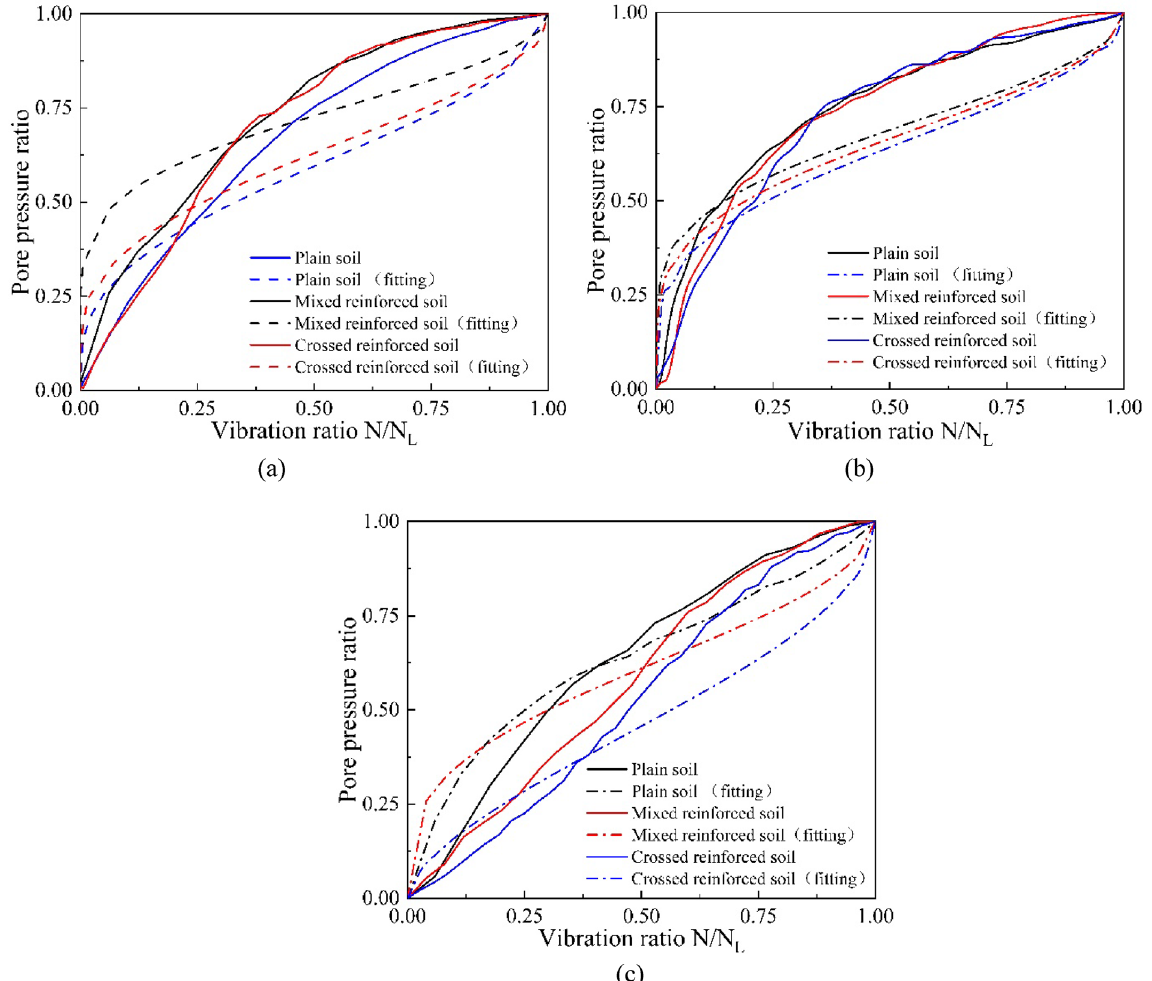
Figure 9. Relationship between pore pressure ratio and vibration ratio computed by Seed model: ( a ) dynamic stress amplitude of 15 kPa, ( b ) dynamic stress amplitude of 20 kPa, and ( c ) dynamic stress amplitude of 25